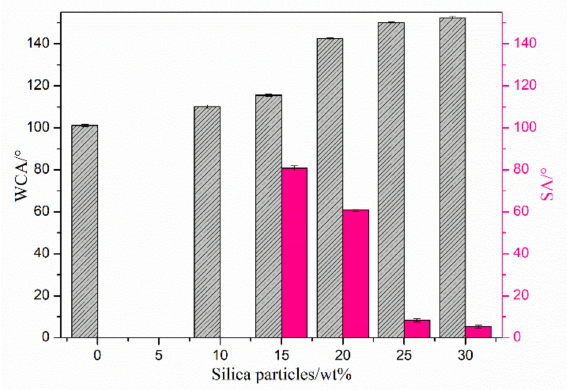
Figure 5. Static water contact angle (WCA) and sliding angle (SA) of the surfaces with di ff erent content of silica particles.